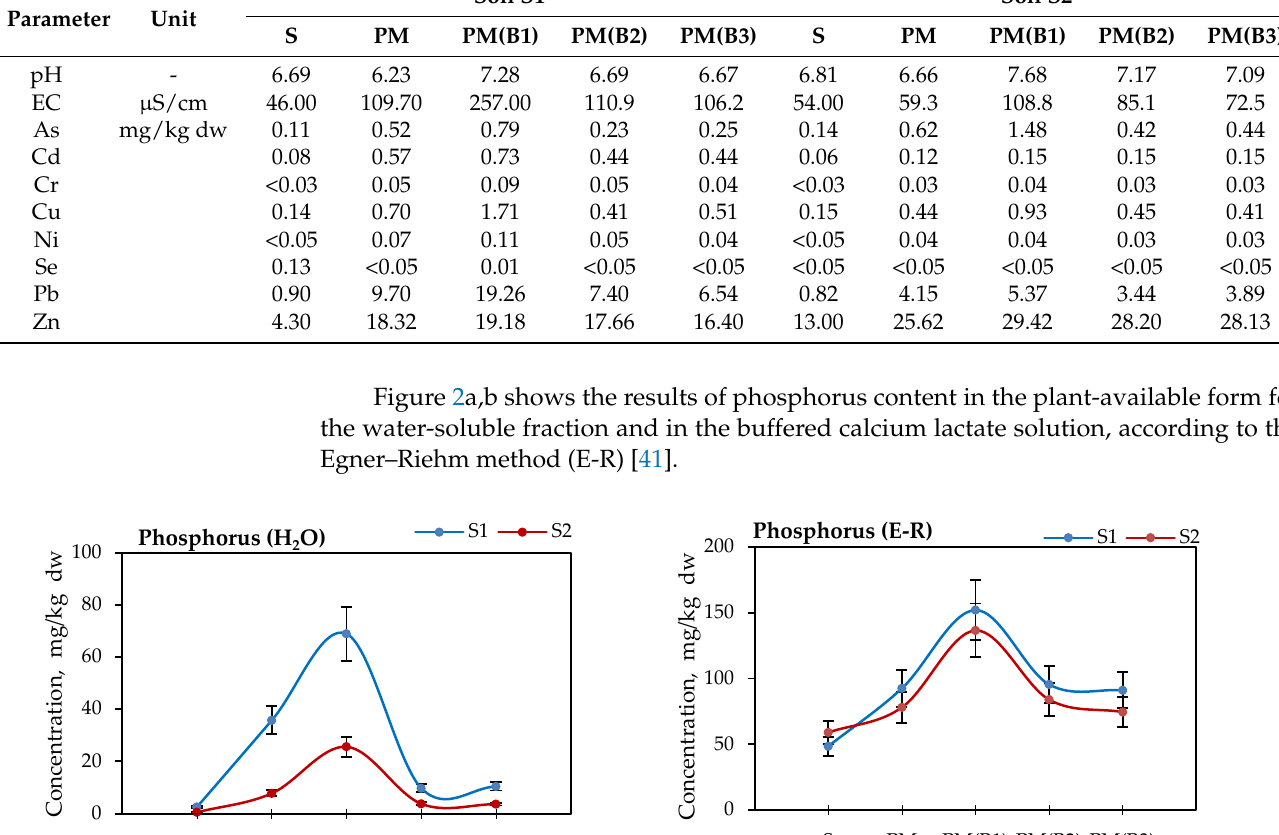
Table 2. Physicochemical analysis of water extracts from the tested soils and their blends. Parameter